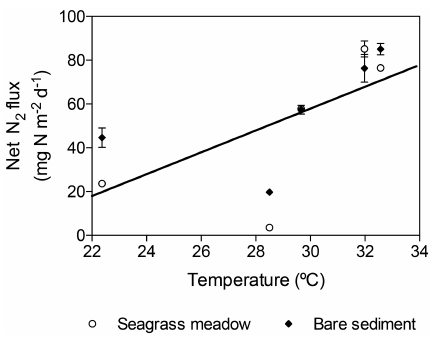
Figure 7. Linear increase (solid line) of net N 2 fluxes in vegetated (white dots) and bare (black diamonds) sediments. Error bars indi- cate